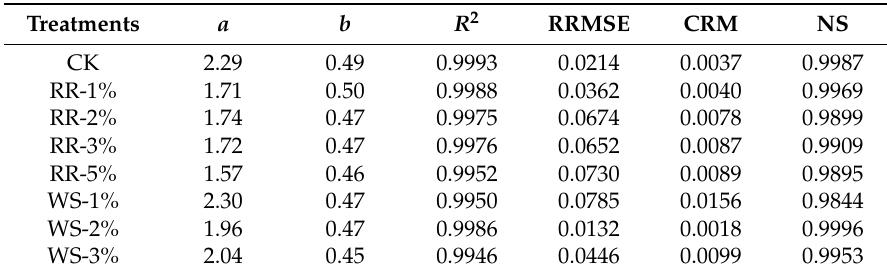
Table 1. Fitting parameters and error analysis of the relationship between wetting front migration distance ( F ) and infiltration duration ( t ) (described as F = a · t b ).